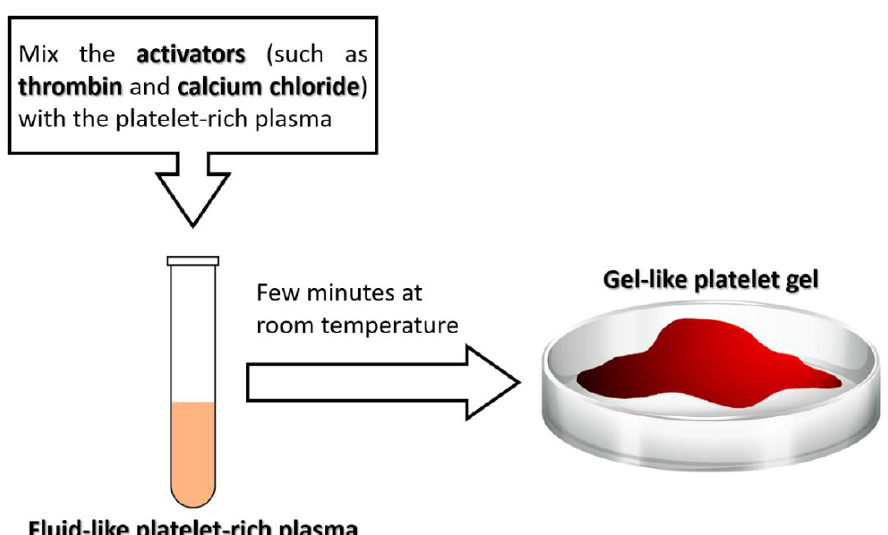
Figure 1. Illustration of gel-like platelet gel and fluid-like platelet-rich plasma.